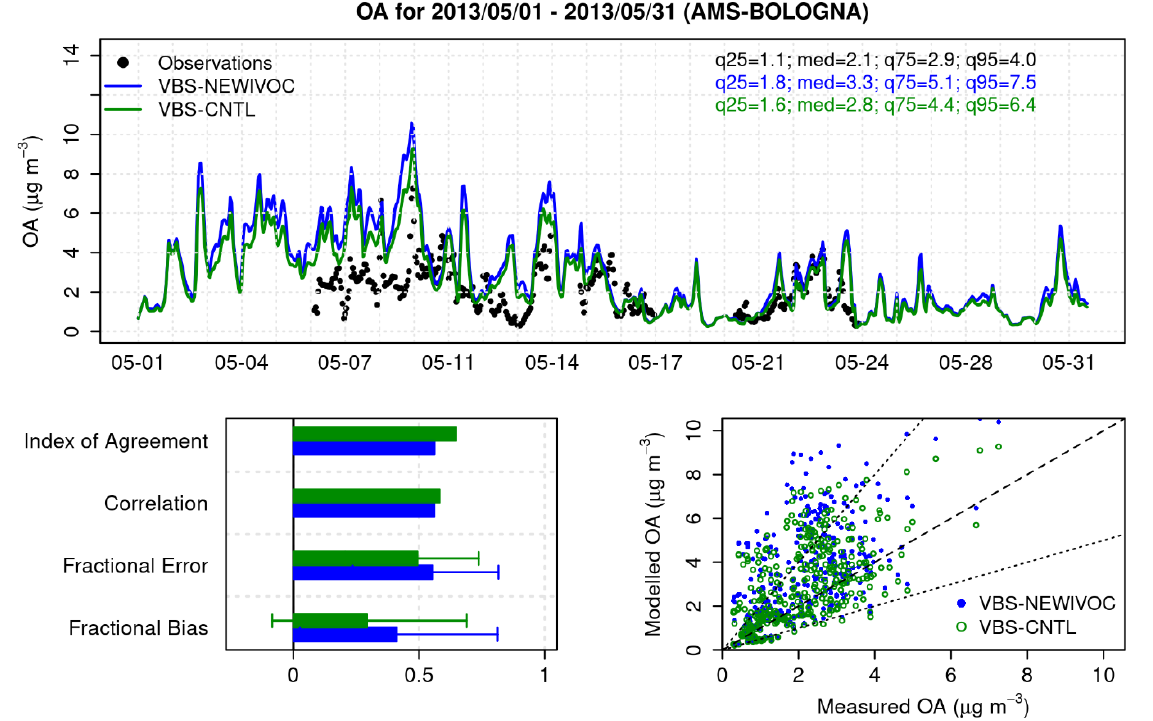
Figure 8. Comparison among modeled and observed (black) OA concentrations in May 2013 at the Bologna site: VBS base scheme (VBS-CNTL, green) and VBS scheme with new parameterizations for IVOC emissions (VBS-NEWIVOC, blue).